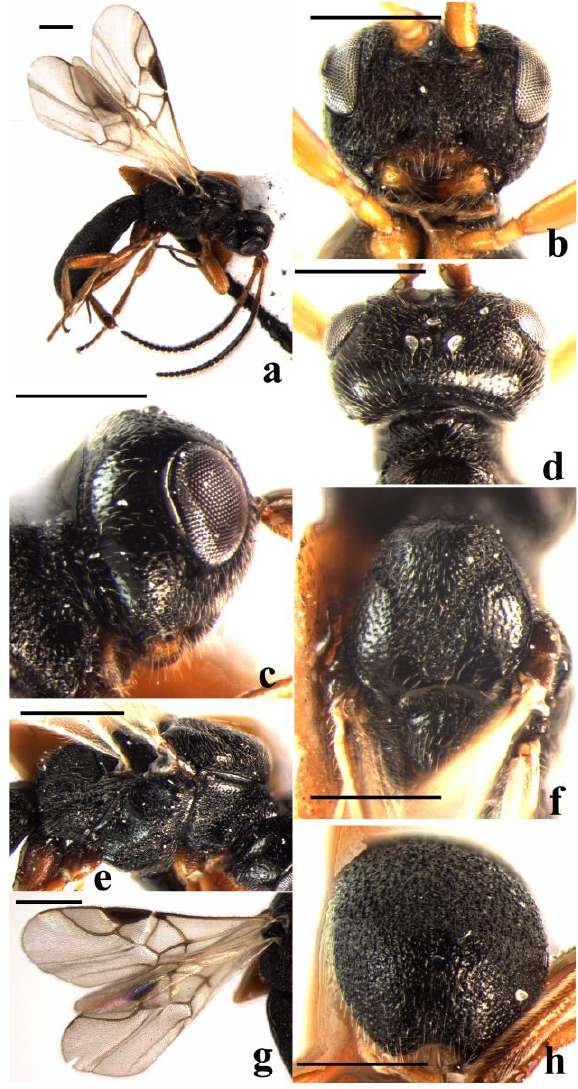
Figure 7. Schizoprymnus subspinosus sp. nov., holotype, ♀ . ( a ) Habitus, lateral aspect; ( b ) head, frontal aspect; ( c ) head, lateral aspect; ( d ) head, dorsal aspect; ( e ) mesosoma, lateral aspect; ( f ) mesoscutum, dorsal aspect; ( g ) fore wing; ( h ) carapace, posterior aspect. Scale bar: 1 mm. Wings. Fore wing: pterostigma about 3.0 times as long as wide; 1-R1 as long as pterostigma; r: 3-SR + SR1: 2-SR =7: 55: 20; 1-SR + M smoothly curved; SR1 strongly curved; cu-a interstitial; m-cu antefurcal. Hind wing: 1-M: 1r-m = 23: 10; M + CU: 1-M = 38: 23; cu- a smoothly curved. finely punctate medially, laterally reticulate; scutellar sulcus is deep, with one median carina and several lateral carinae; scutellum convex, punctate anteriorly and rugose-punctate posteriorly; surface of the propodeum is